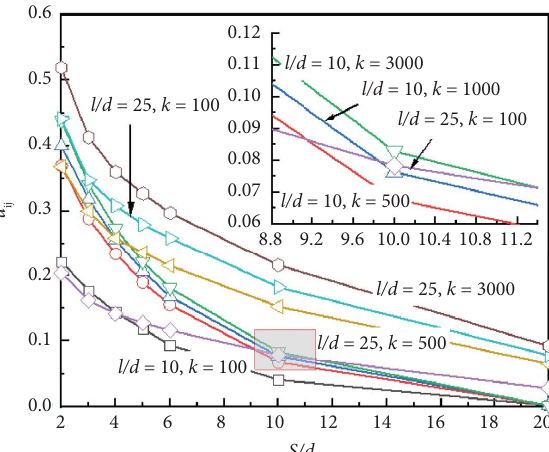
Figure 4: Infuence of S / d on the pile-pile interaction factor ( l/d � 10, l / d �